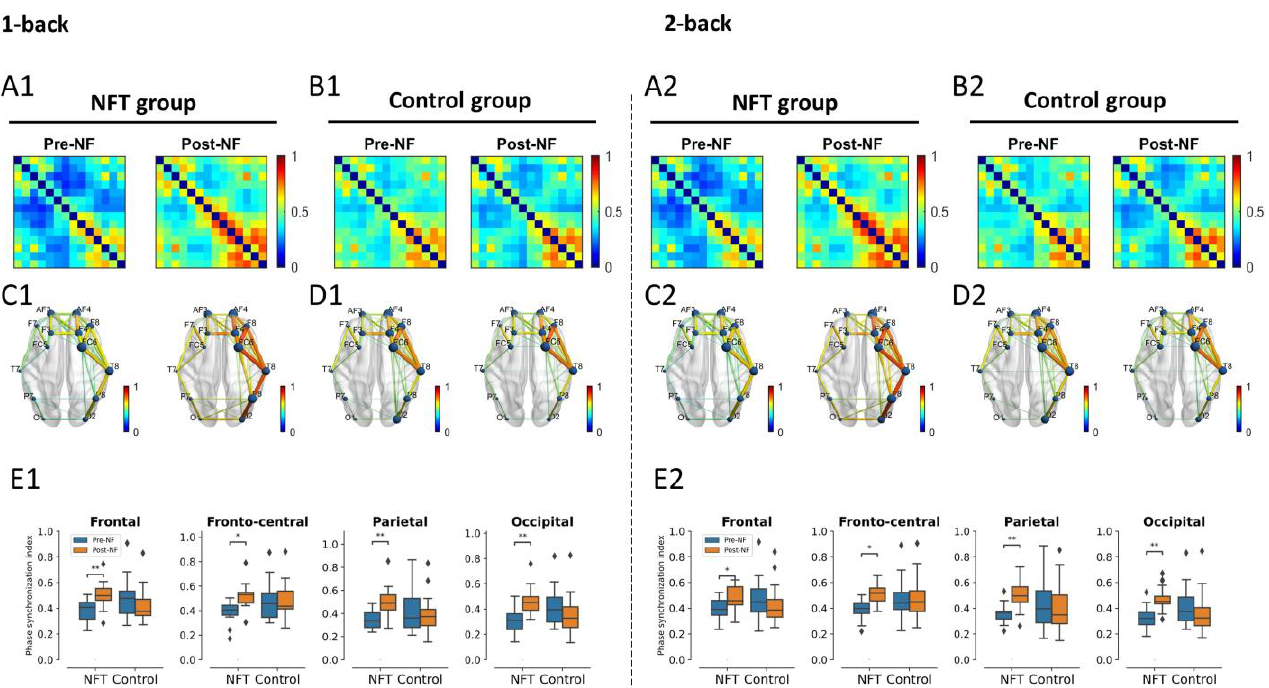
Figure 9. Theta band functional connectivity (* p < 0.05, ** p < 0.005). Connectivity matrices shown in ( A1 ) for NFT group and ( B1 ) for control group and brain connections in ( C1 ) for NFT group and ( D1 ) for control group in 1-back condition. Similarly, connectivity matrices shown in ( A2 ) for NFT group and ( B2 ) for control group and brain connections in ( C2 ) for NFT group and ( D2 ) for control group in 2-back condition. The box plots in ( E1 , E2 ) show the phase synchronization index in different brain lobes in 1-back and 2-back conditions, respectively. The colour bar of the connectivity matrices and brain connections represent the strength of synchronization between the EEG channels. It ranges from 0 (no synchronization) to 1 (full synchronization). The diamond shape in the box plots represents the outliers in the data.